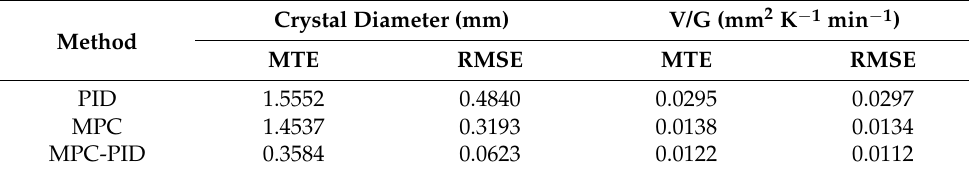
Table 4. MTE and RMSE of control output error under square wave